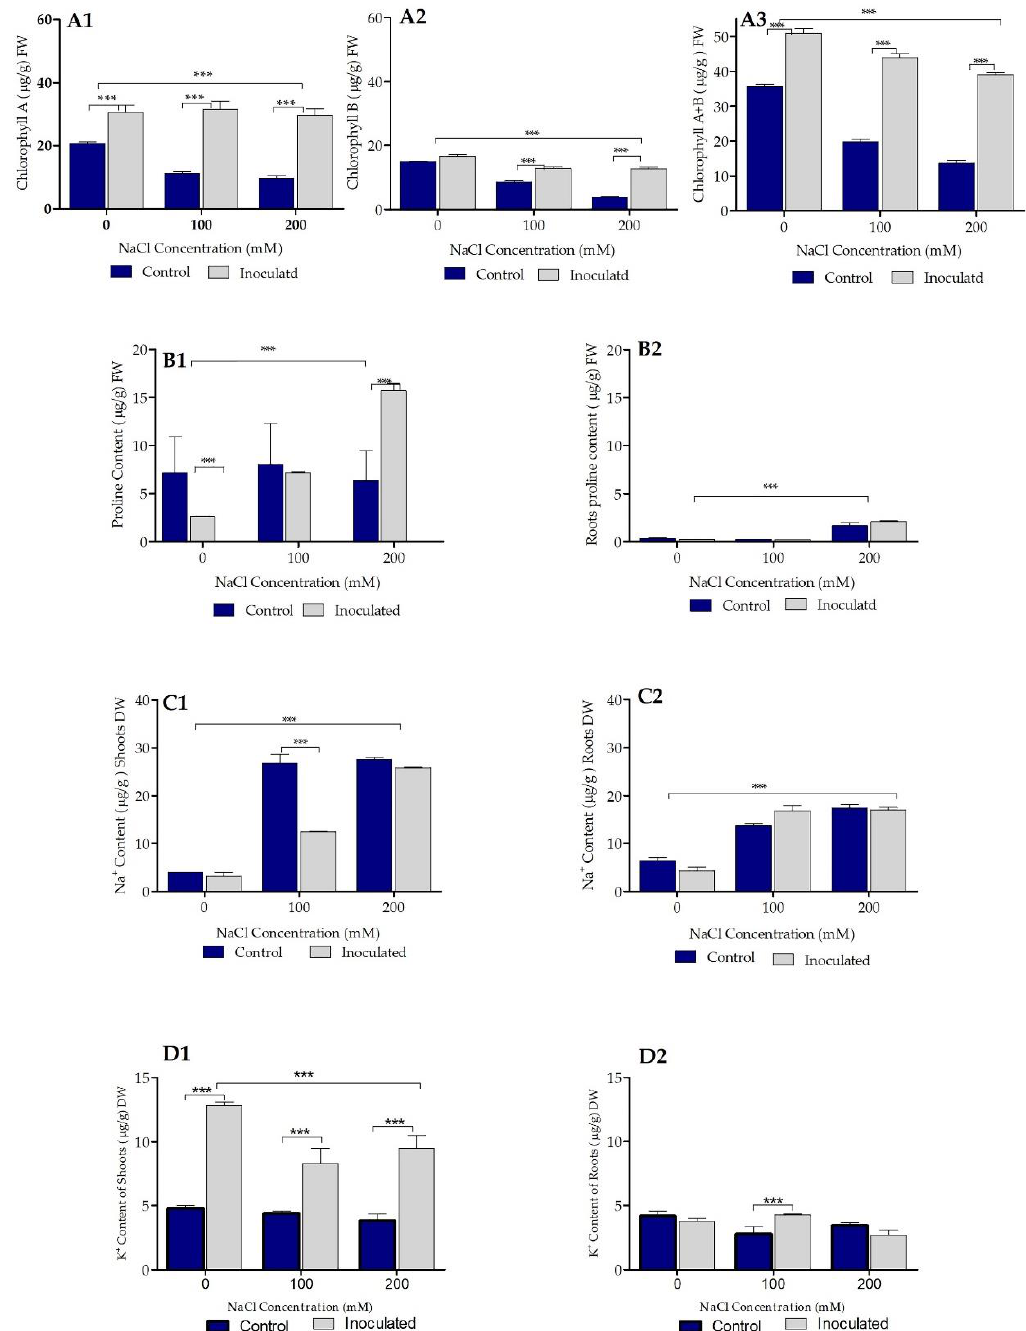
Figure 6. E ff ect of PGPR P. agglomerans strain Pa inoculation on biochemical parameters of durum wheat cv Waha grown in saline and non-saline settings in soil pots. ( A1 , A2 , A3 ) E ff ect of bacterial inoculation (isolate Pa) on chlorophyll a, b, and a + b contents ( µ g / g FW) in wheat plants grown in soil with the presence of three NaCl concentrations (0, 100, and 200 mM). ( B1 , B2 ) E ff ect of bacterial inoculation (isolate Pa) on proline content ( µ g / g FW) in the presence of three concentrations (0, 100, and 200 mM) of NaCl in soil-grown wheat plants. ( C1 , C2 ) E ff ect of bacterial inoculation (isolate Pa) on Na + content ( µ g / g DW) in the presence of three concentrations (0, 100, and 200 mM) of NaCl in wheat plants grown in soil. ( D1 , D2 ) E ff ect of Pa inoculation on K + content ( µ g / g DW) in the presence of three NaCl concentrations (0, 100, and 200 mM) in wheat plants grown in soil. The bar plots represent the mean ± standard error of three di ff erent experiments. We used GraphPad Prism 8 to perform statistical analysis, using two-way ANOVA followed by Tukey’s multiple comparison post-test. Only significant variations are displayed: *** p <